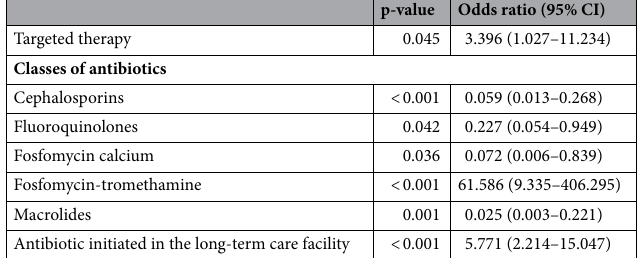
Table 4. Multivariable analysis of variables associated with